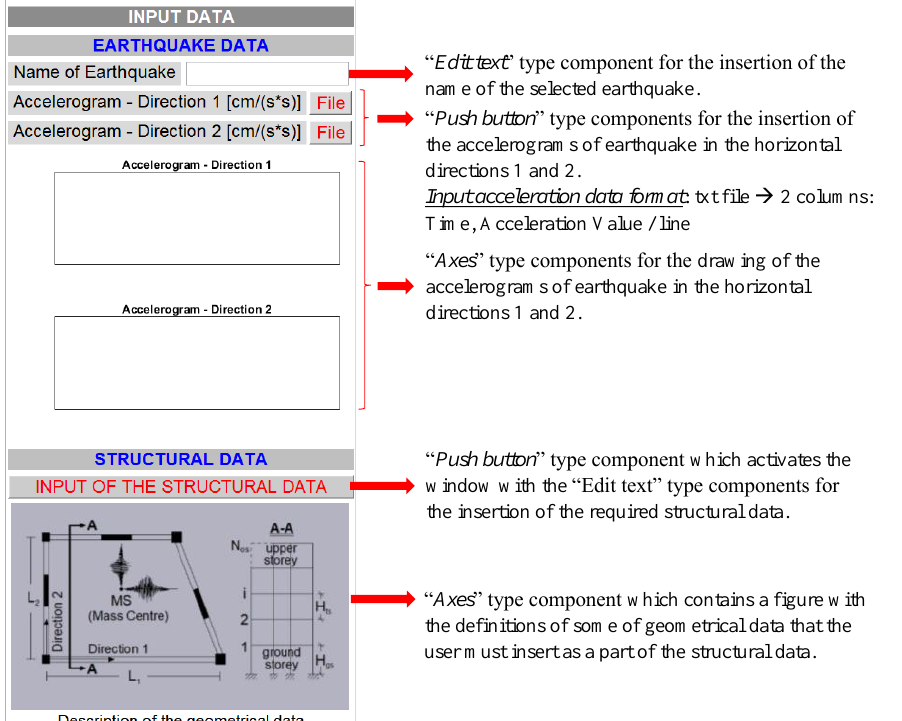
Figure 5. Brief description of the GUI control tools/components of the panel “INPUT DATA”. The two push buttons entitled “FILE” activate a window with a file selector for the selection of the accelerograms of the earthquake excitation (in text file format) in directions 1 and 2 (Figure 6).